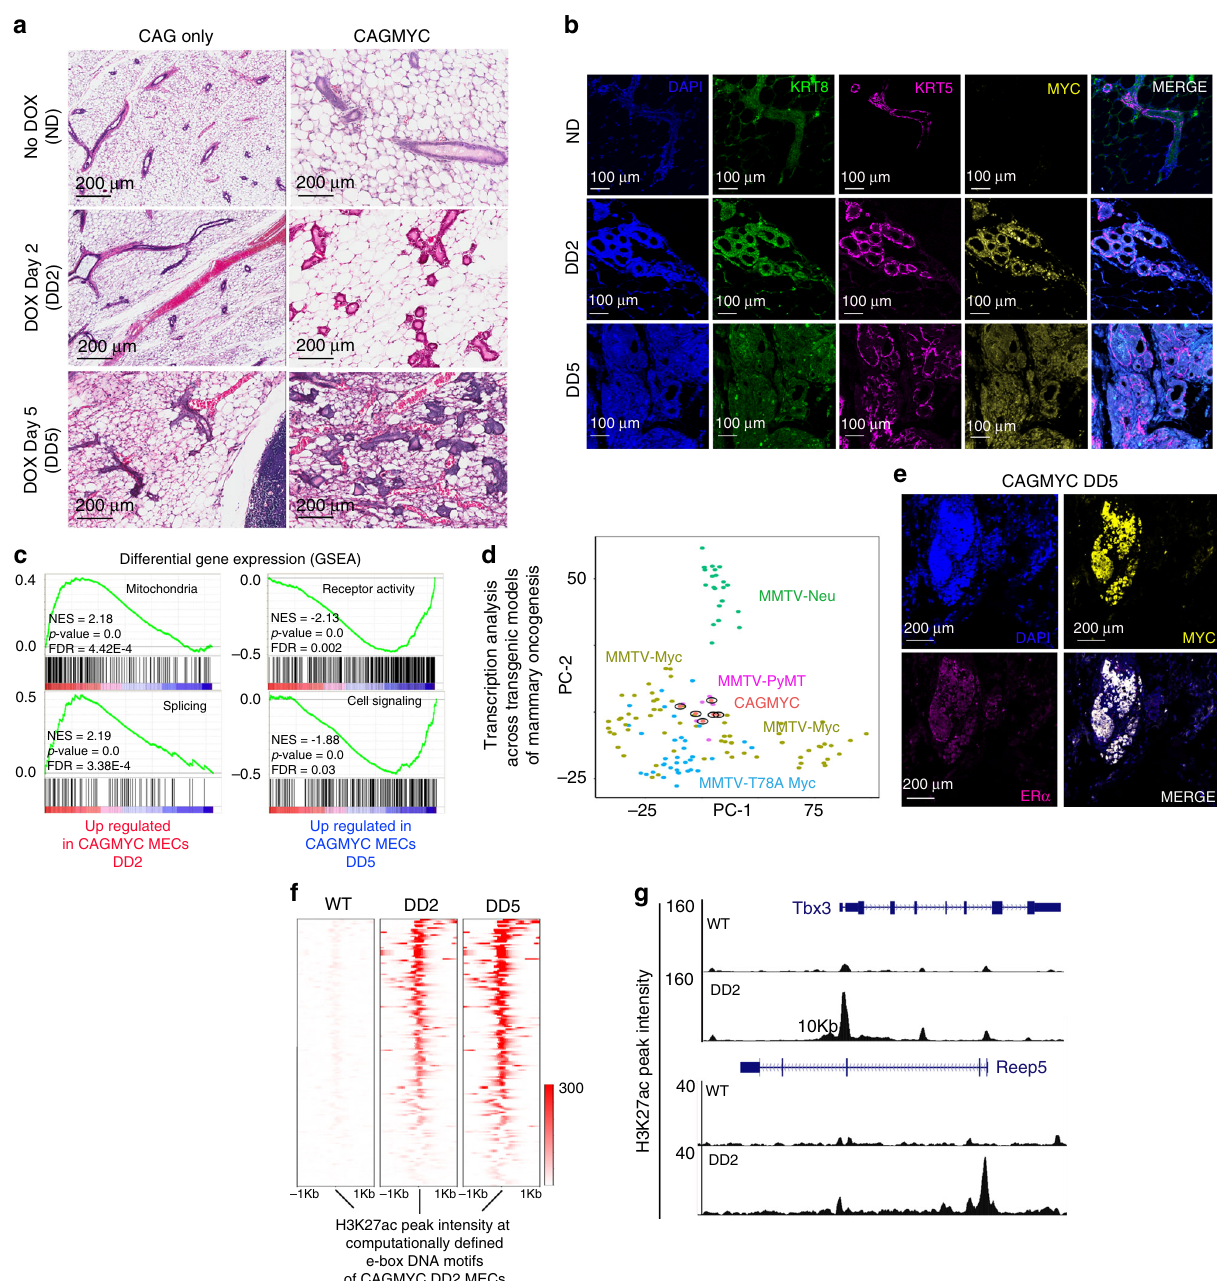
Fig. 2 cMYC overexpression and mammary premalignant lesion development. a H&E-stained mammary gland images from nulliparous CAG only and CAGMYC female mice, with no DOX treatment (ND) and treated with DOX for 2 days (DD2) and for 5 days (DD5). Scale: 200 µ m. b Immuno fl uorescence images of mammary glands from nulliparous CAGMYC female mice, with no DOX treatment (ND), and treated with DOX for 2 (DD2) and 5 days (DD5), visualizing DAPI (blue), KRT8 (green), KRT5 (magenta), and cMYC (yellow). Scale: 100 µ m. c GSEA analysis of transcriptional programs enriched in CAGMYC total MECs harvested from nulliparous female mice treated with DOX for 2 days (DD2) and for 5 days (DD5). NES normalized enrichment score. d Principal component analysis of gene expression levels from CAGMYC total MECs harvested from nulliparous female mice treated with DOX, compared with publicly available gene expression datasets generated using tumor tissue from transgenic mouse models of mammary